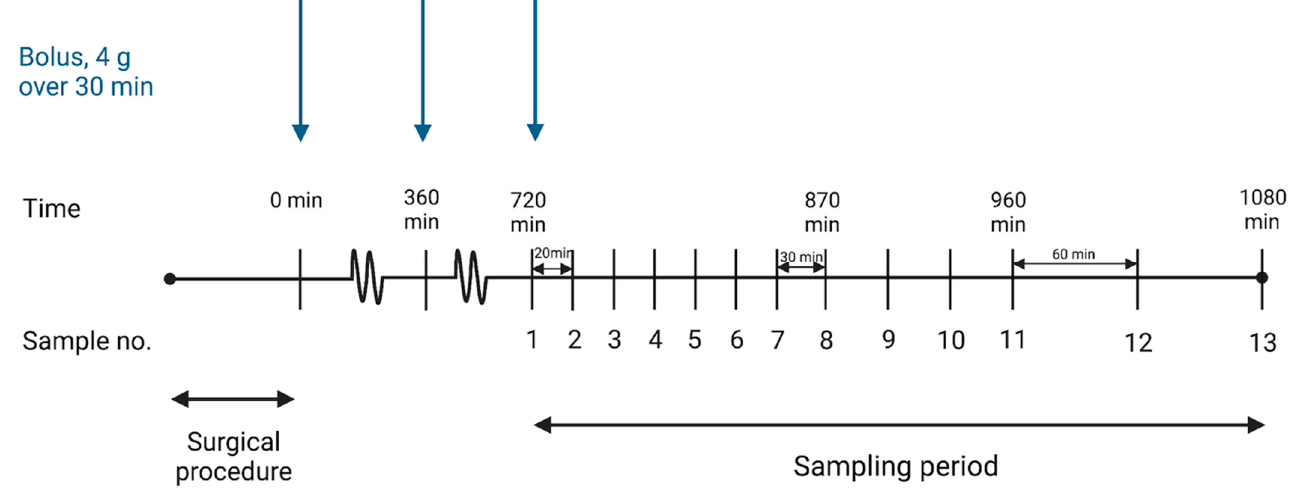
Figure 3. Timeline illustrating the sampling intervals and administration of piperacillin. Figure 3 was made using Biorender with permission for publication from Biorender [40].